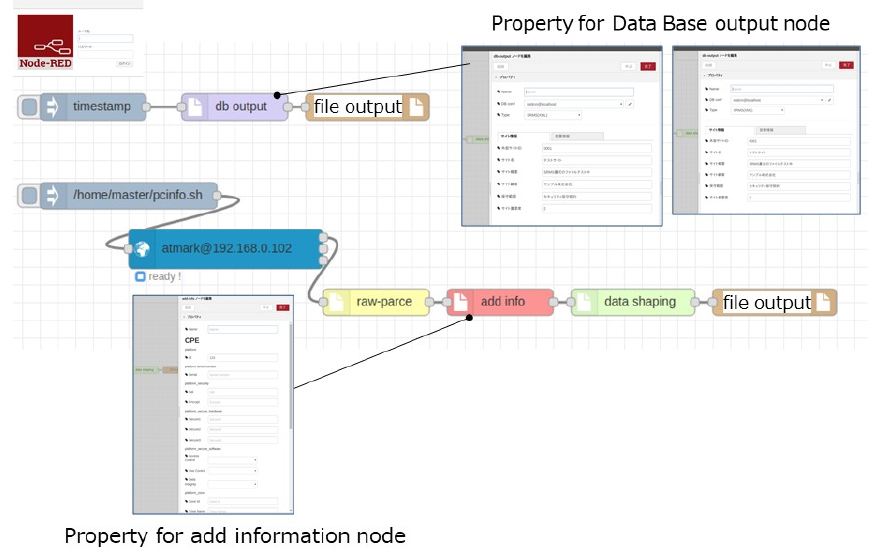
Figure 5. GUI example for asset configuration management.